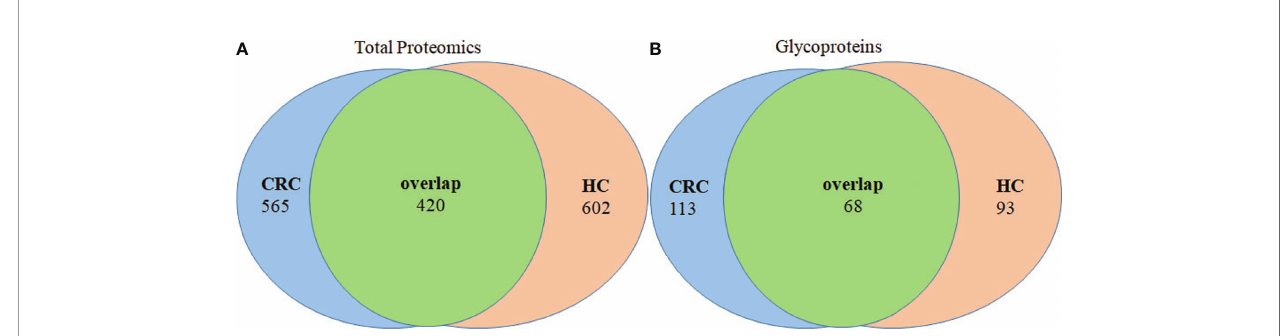
FIGURE 3 | Venn diagram of proteins of paracancerous tissues and cancer-tissue exosome samples isolated from patients with CRC. (A) The distribution of total proteins and (B) unique